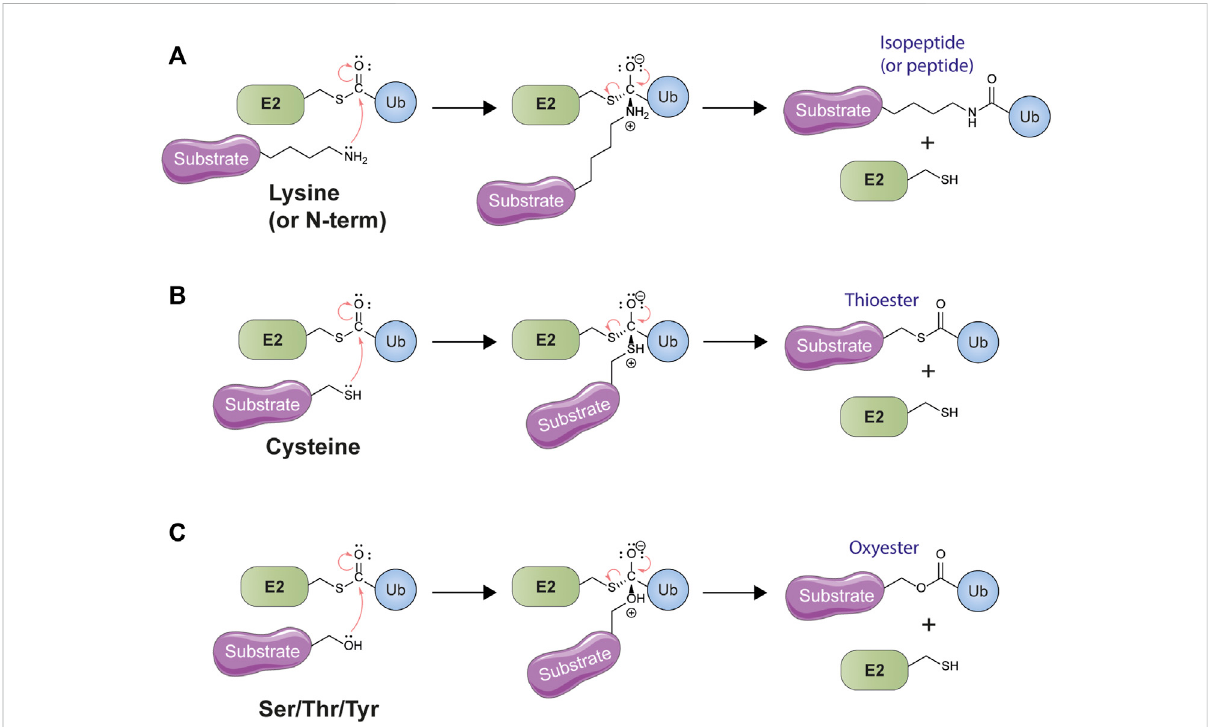
FIGURE 2 Canonical and non-canonical ubiquitylation both represent examples of nucleophilic acyl transfer. (A) Conventional ubiquitylation involvesthe attack of the electrophilic thioester carbonyl of an E2-ubiquitin (Ub) conjugate by the lone pair electrons of the substrate lysine amine group. This leads to theformation and then collapse ofatetrahedral intermediate, expelling the E2 leaving group and resulting in lysine ubiquitylation. The same mechanism may also be employed to ubiquitylate the free amine group of the N-terminus of the polypeptide backbone. (B) Like nitrogen, the cysteine thiol also possesses a lone pair of electrons and can act as a nucleophile in an acyl transfer reaction. This same mechanism is employed by E2s themselves when they accept ubiquitin from the E1 enzyme, as well as by the transthiolating E3 ligases. This reaction leads to the formation of a thioester. (C) The amino acids serine, threonine, and tyrosine possess a nucleophilic hydroxyl group which can be ubiquitylated by means of a nucleophilic acyl transfer mechanism. The resulting linkage between ubiquitin and the substrate is an